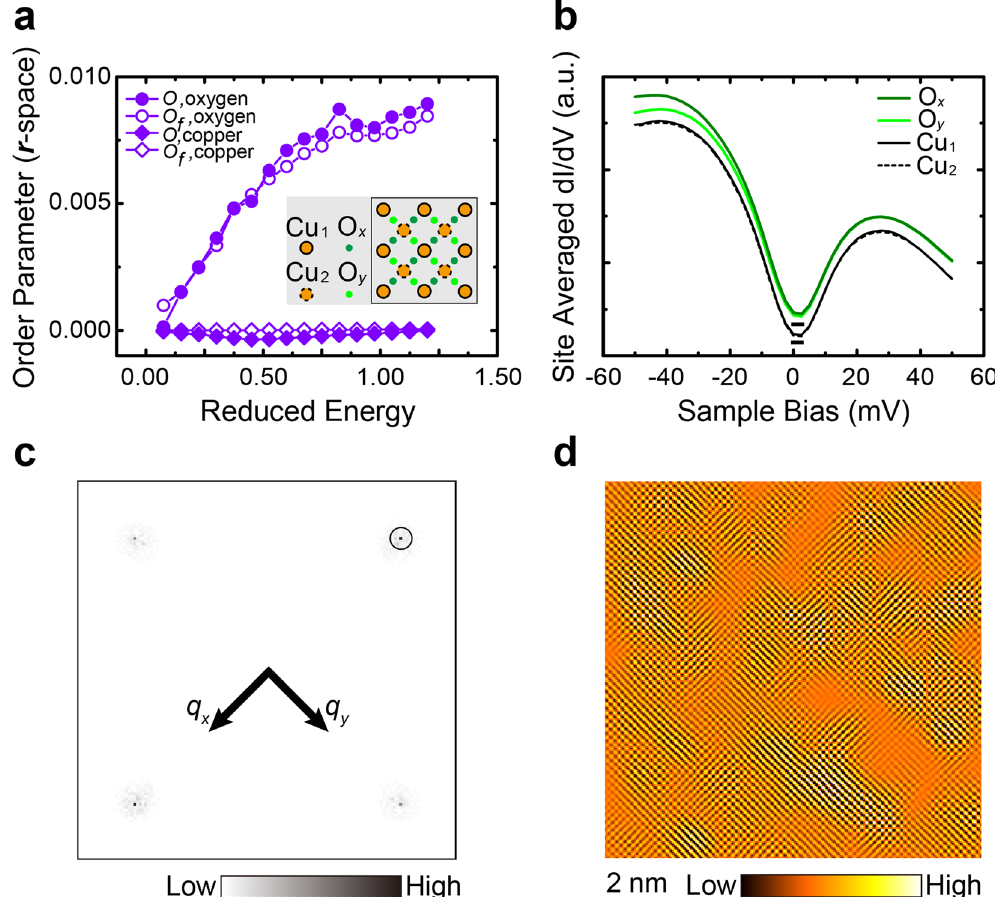
Figure 3. Filtered Z -map and collective nematic order ( r -space). ( a ) The collective order parameter in the real space as a function of ε . The lines with filled circles and diamonds are the results of O ( ε ) from the O and Cu sites, respectively. The lines with open circles and diamonds are the results of O f ( ε ) from the same two types of sites after the filtration. The inset is a schematic of CuO 2 layer. ( b ) The averaged spectra on four different types of atomic sites (O x , O y , Cu 1 , and Cu 2 as labeled in the inset of panel a). The spectra for O sites are offset vertically →∼ for clarity. ( c ) The filtered ratio ε Z q ( , ) f map in the momentum space after a Gaussian filtration around the four Bragg peaks. A circle centered at Q x with the radius Λ − 1 = 1.05 nm is drawn to show the filtering size. ( d ) → The filtered ratio ε Z r ( , ) f map after the inverse Fourier transform of panel